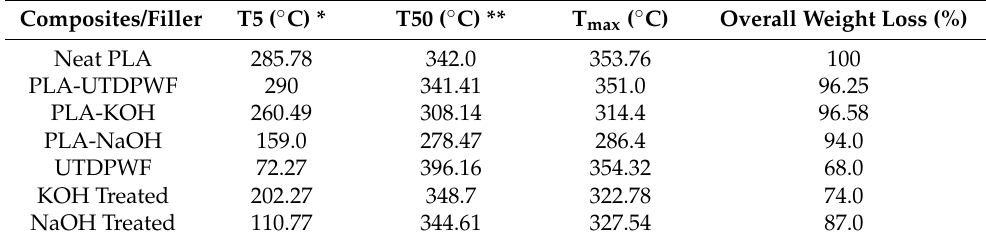
Table 3. Decomposition temperature and overall change in weight of the composites and